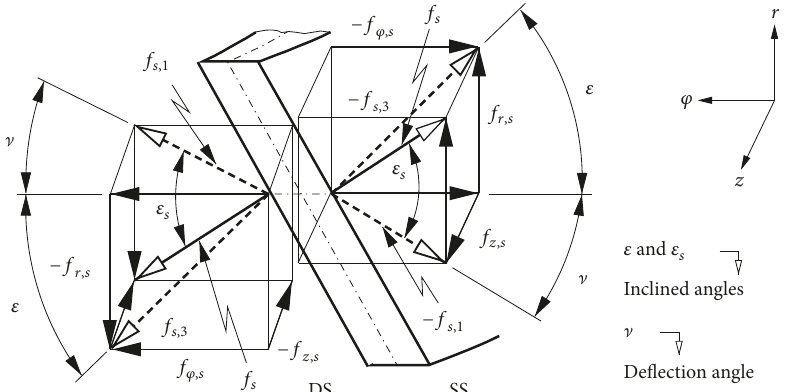
Figure 7: Schematic representation of 3D-blade forces and angles on the surface element of inclined or curved guide vane as a definition of the force direction (DS = pressure side; SS = suction side).